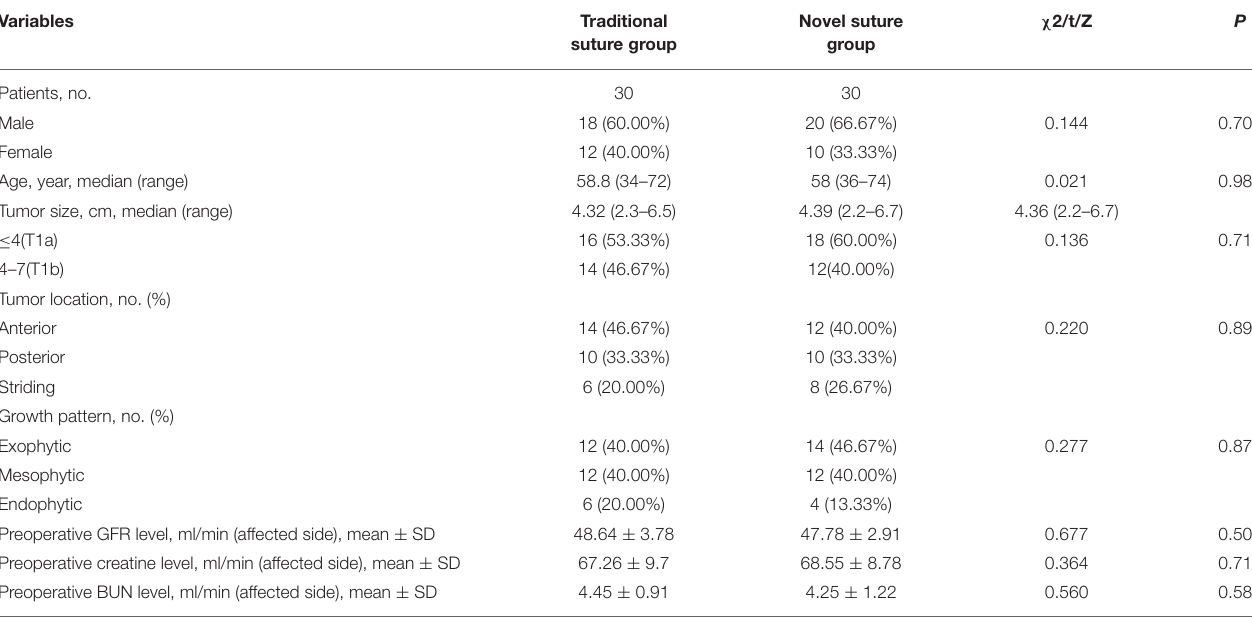
TABLE 1 | Overall patients baseline demographic data and preoperative information. Variables Traditional